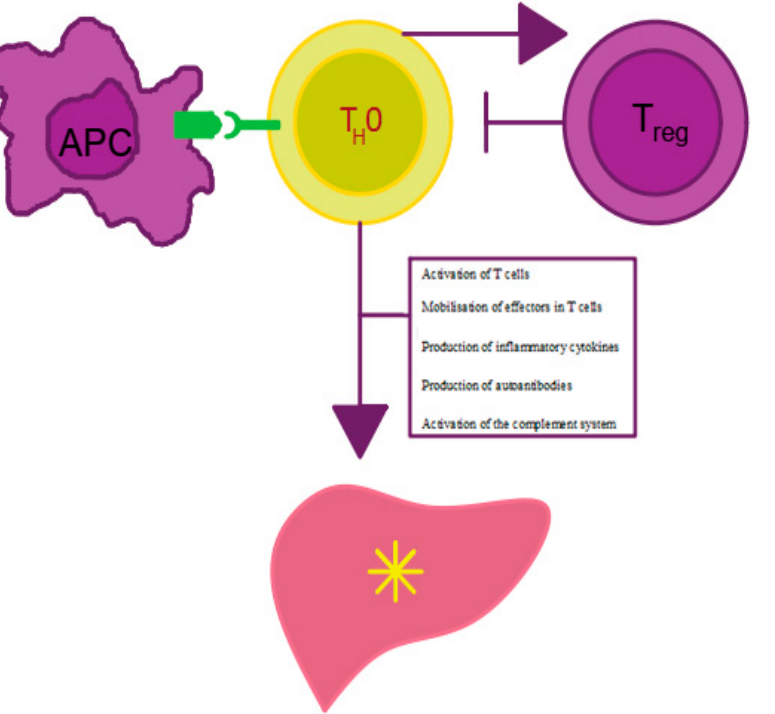
Figure 1. Mechanism of AIH development. APC—antigen presenting cell, Treg—regulatory T cell, Th0—T helper cell. Own elaboration based on [16]. Antigen presentation by APC cells to Th0 lymphocytes leads to effector mobilization on Treg cells and proinflammatory cytokine production. The cytokines stimulate antibody maturation and production by B lymphocytes and inhibit Treg